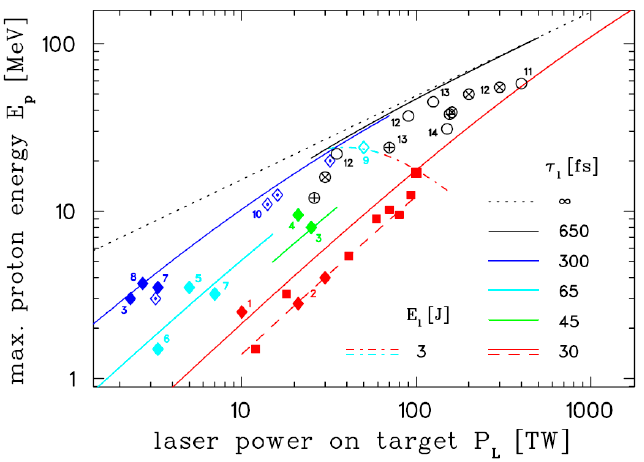
Figure 5. Energy scaling of the accelerated protons as a function of the laser power on target, as well as pulse width. The many different contributions from various authors are given in [34]. Reproduced from [34]. Copyright 2010, IOPscience.